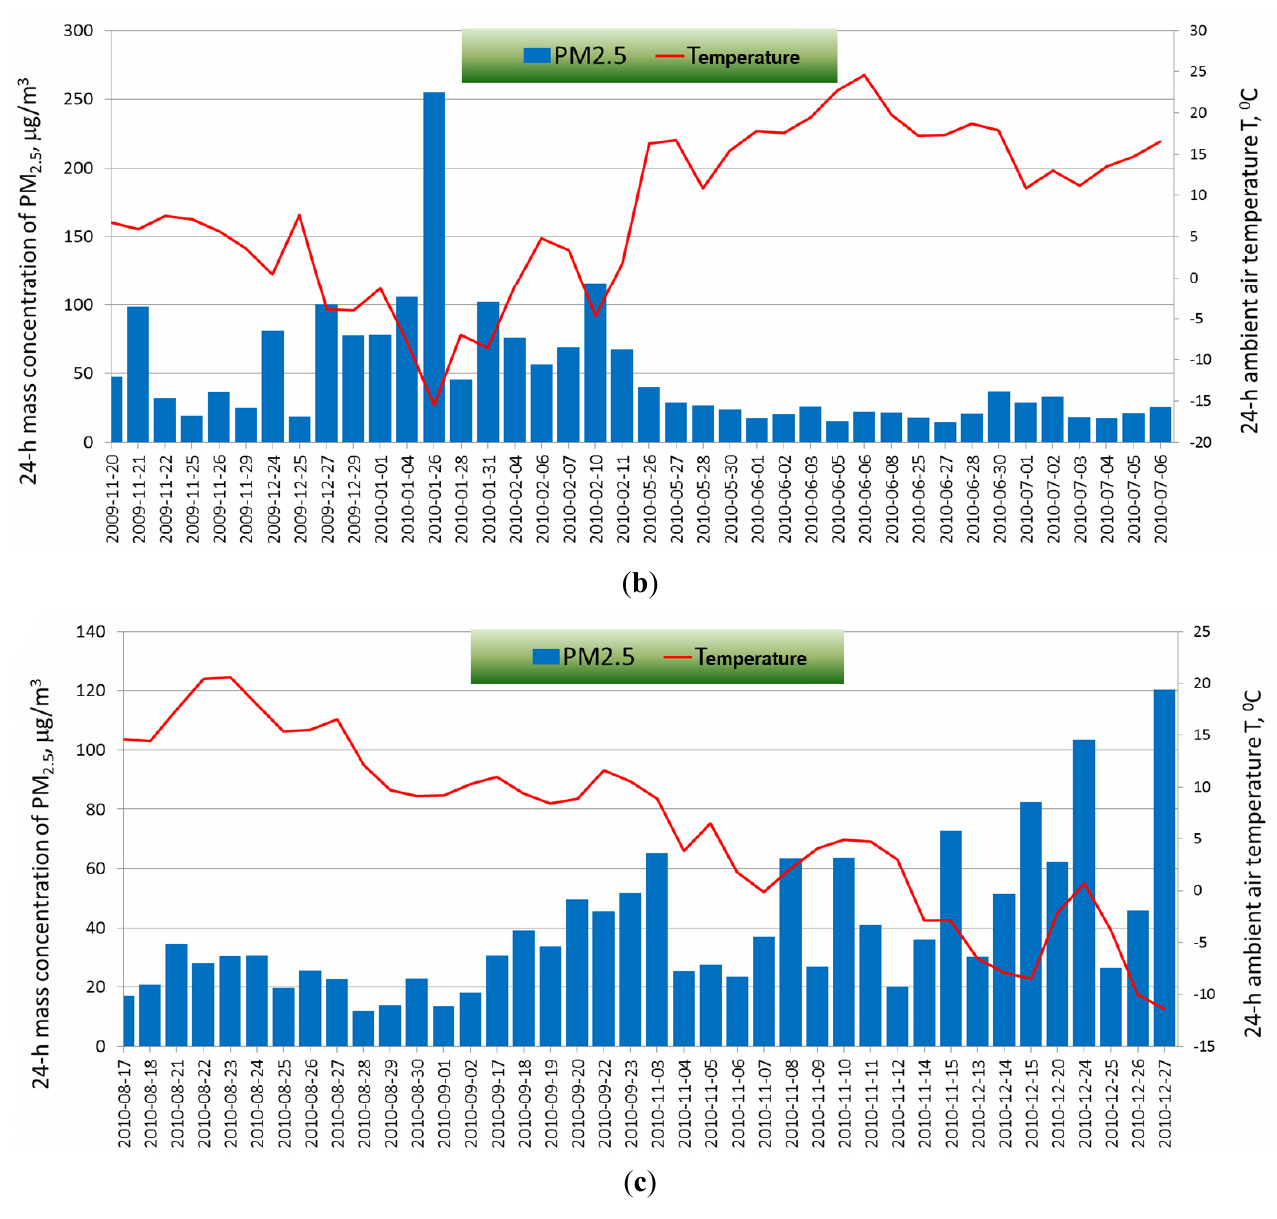
Figure 2. 24-h mass concentrations of PM 2.5 at regional background site, RB ( a ), at urban background site, UB ( b ) and at urban traffic site, UT ( c